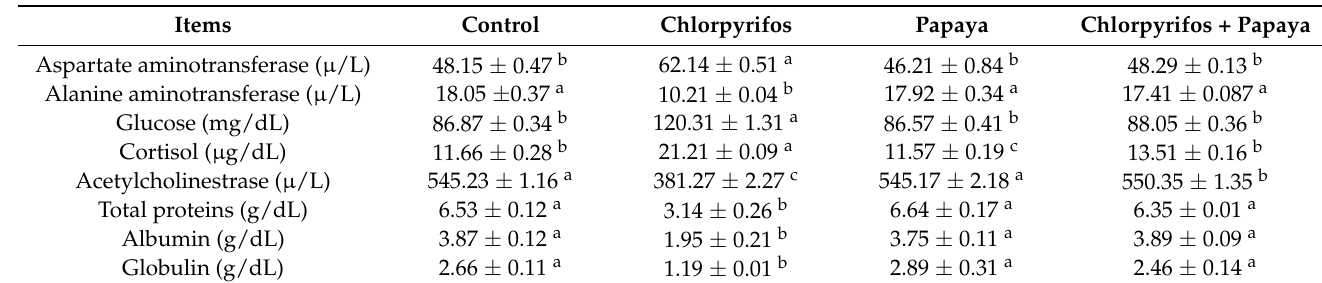
Table 2. Blood biochemical parameters in female African catfish exposed to chlorpyrifos (8.75 µ g/L.) and/or co-administrated with papaya, Carica papaya , aqueous extract (250 mg/kg body weight) for 6